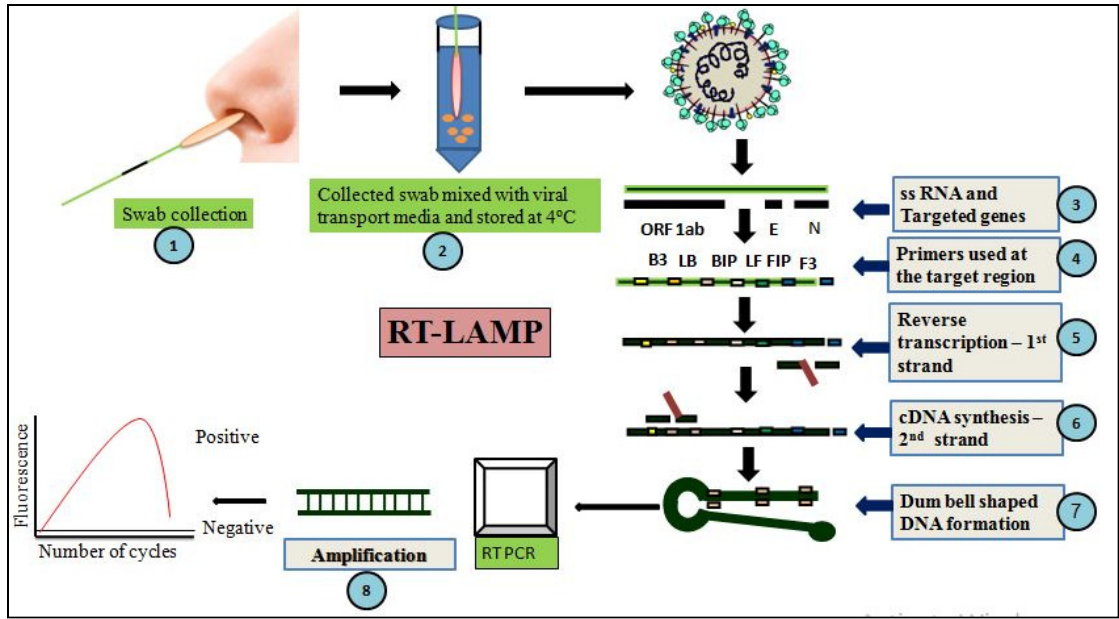
Figure 2. RT-LAMP technique-based detection of SARS-CoV-2 infection: ( 1 ) collection ofhuman samples; ( 2 ) mixing of the collected sample with viral transport media and storageat 4 °C until use; ( 3 ) single-stranded RNA genome of SARS-CoV-2 with the targeted genes; ( 4 ) specific primers binding atthe targeted genes; ( 5 ) synthesizing the first-strand cDNA by reverse transcription; ( 6 ) DNA polymerization for second-strand cDNA synthesis; ( 7 ) dumbbell-shaped DNA formation during the process of cDNA synthesis; ( 8 ) RT-PCR with specific primers/fluorescent markers demonstrates either positive or negative results for SARS-CoV-2 detection.